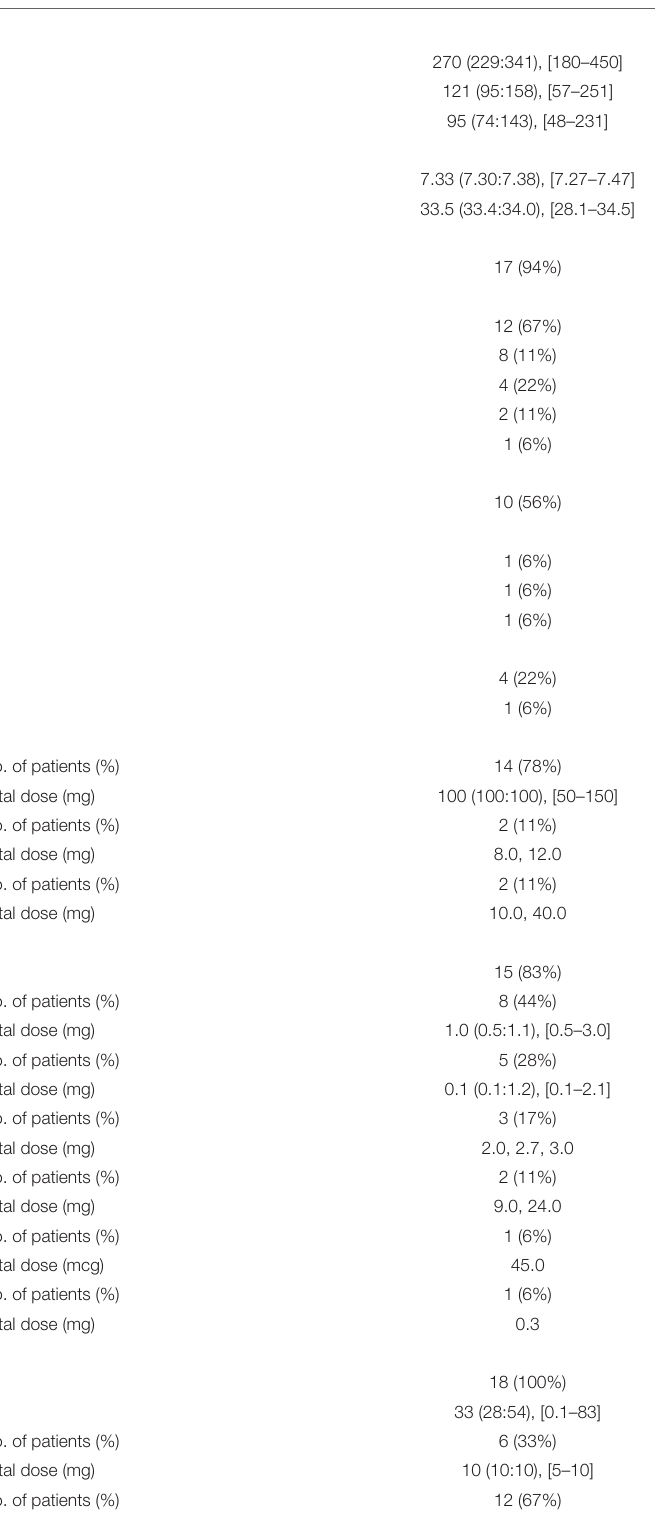
TABLE 5 | Intraoperative variable of nonagenarians undergoing open cardiac surgery.